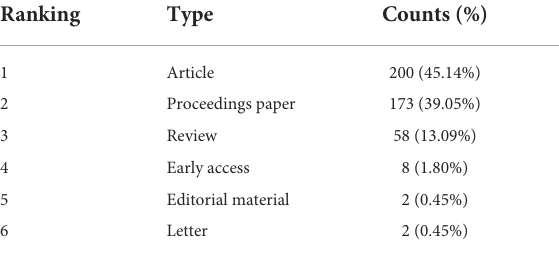
TABLE 2 Document types related to AI on